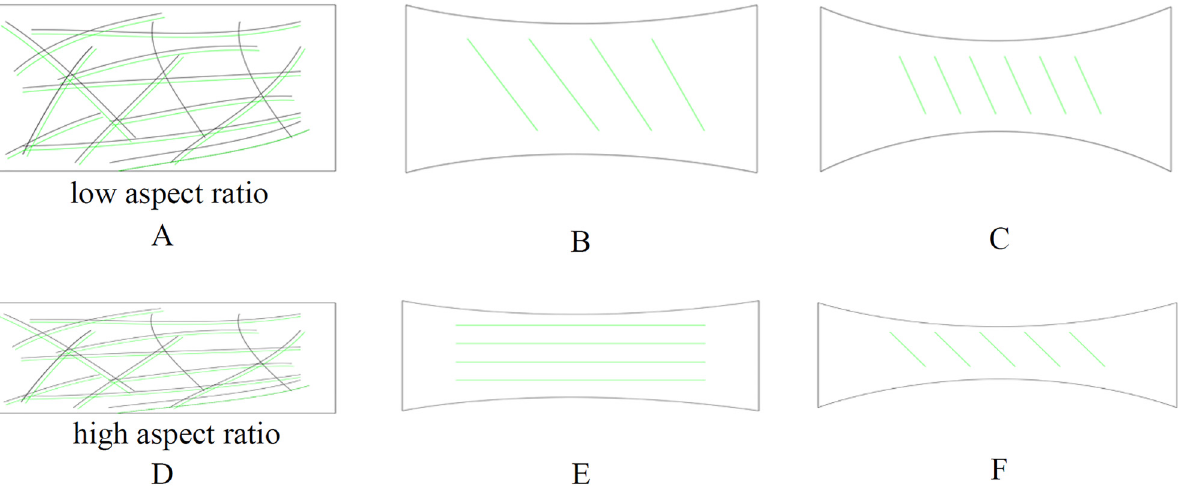
Fig 11. Schematic representation of collagen orientation evolution with time in low (A-C) and high (D-F) rectangular TE strips. The collagen orientation changes by culture time. First, the fibers were randomly oriented. By extending culture time, fibers aligned in the constrained direction in the high aspect ratio strips and in the oblique direction in low aspect ratio strips. By culturing for a longer time, the fibers aligned in the oblique direction in both configurations.